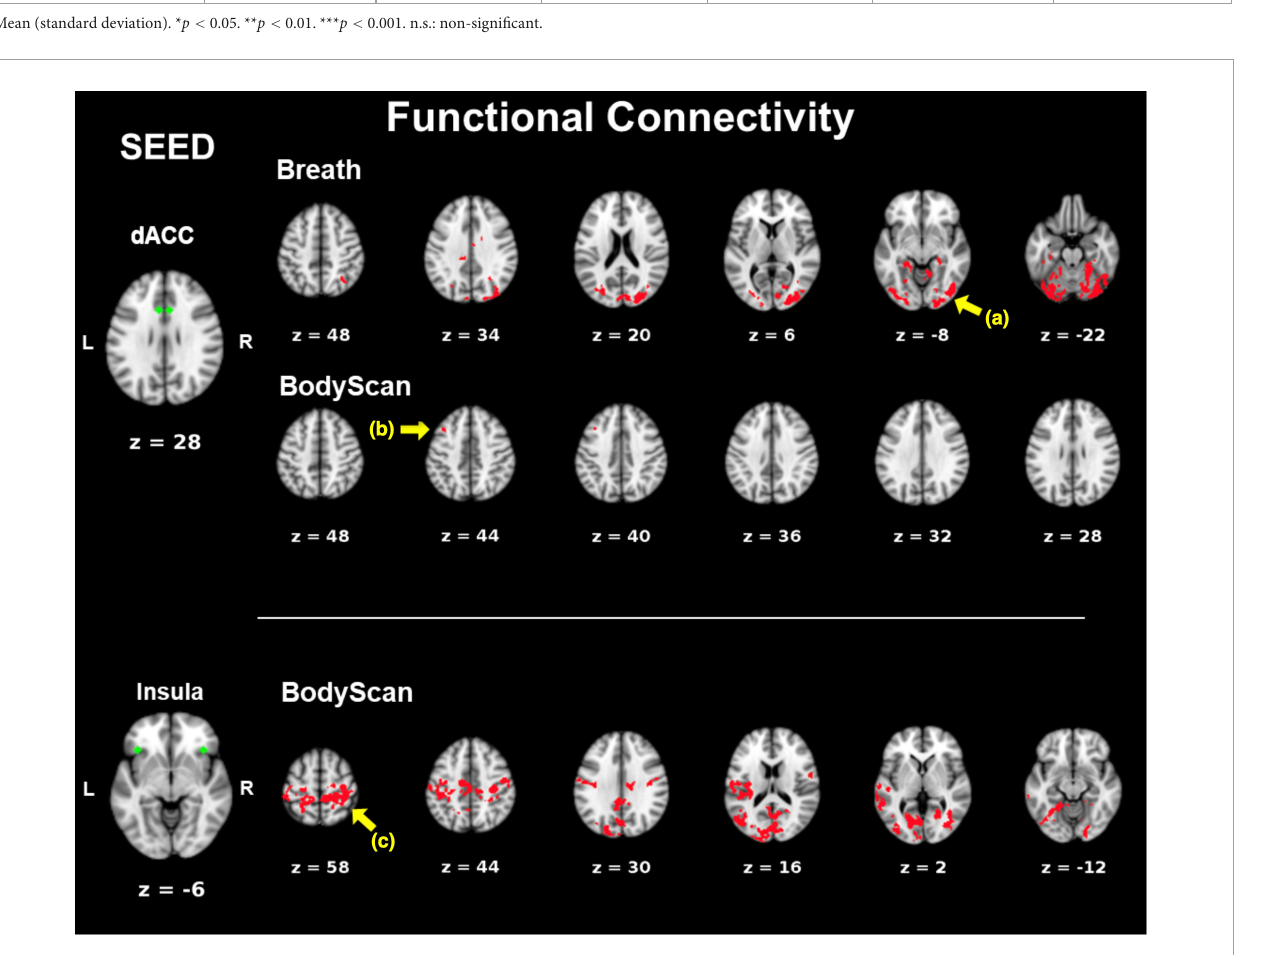
bodily sensations (breathing and body scan) yielded distinct spatial patterns of the SN connectivity, contributing to different facets of mindfulness. As compared with the normal resting state, both interoceptive mindfulness practices changed pattern of brain communication (distant-local in Figure 4 ), but this difference was only apparent after MBSR program. The functional specificity of mindfulness practices offers a novel viewpoint on the altered information processing across mindfulness